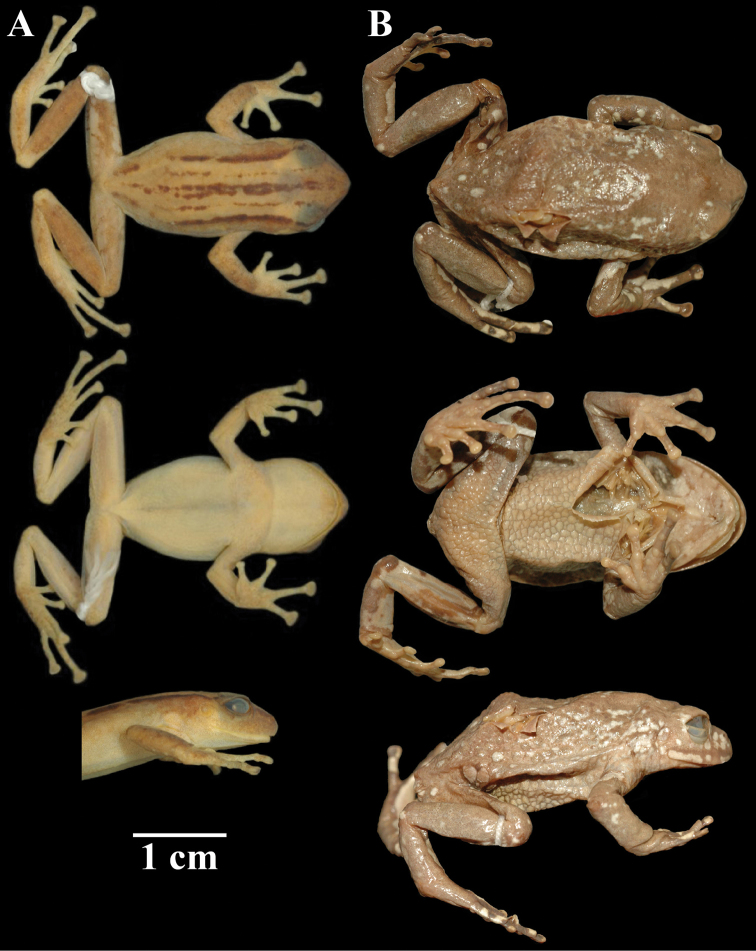
Preserved holotypes of Pristimantis
phoxocephalus and P.
riveti. Dorsal, ventral and lateral views of: APristimantis
phoxocephalus (KU 142075) BPristimantis
riveti (MNHNP 1902.357). Shown at the same scale.